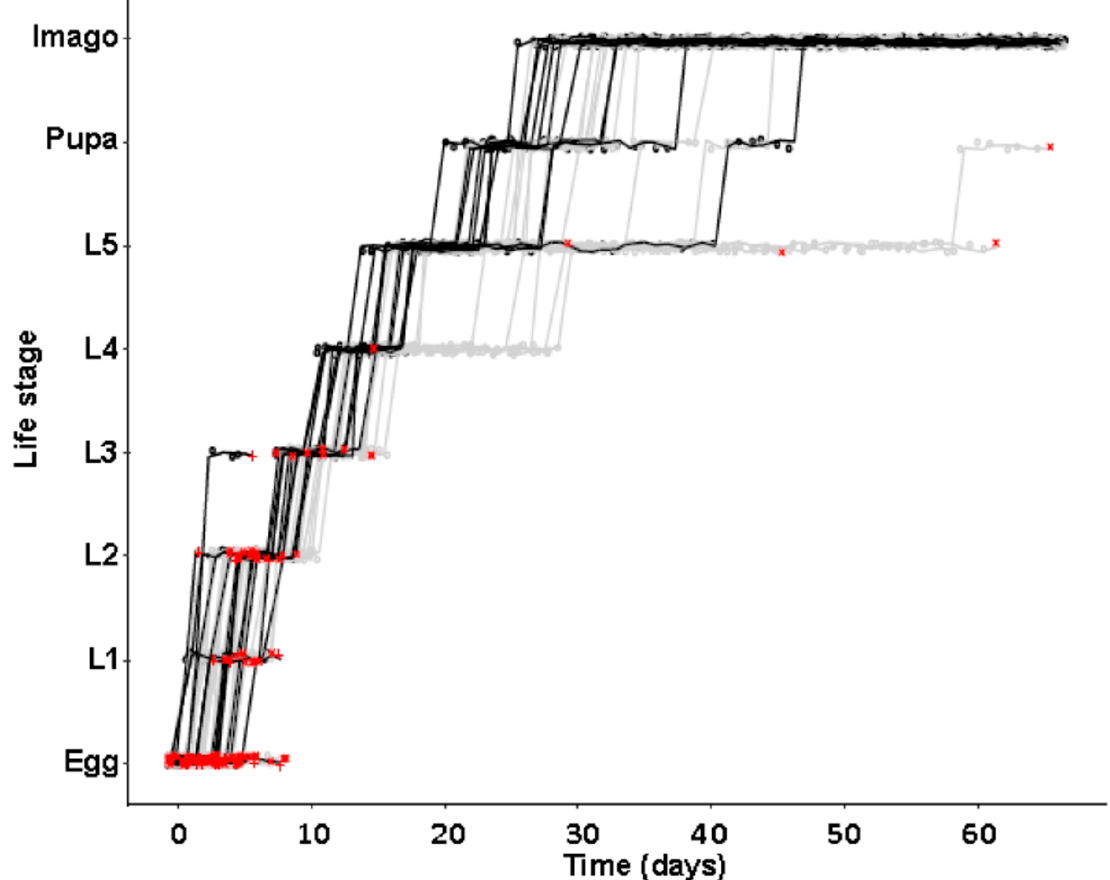
Figure 2. Cumulative developmental time until the end of different life stages of aposymbiotic (grey dots and lines) versus symbiotic (black dots and lines) O. surinamensis beetles from the JKI-1 lines. Red ‘ + ’ and ‘ × ’ signs indicate death of symbiotic and aposymbiotic individuals, respectively. Significant differences were observed for transitioning from larval instars 3 to 4 and instar 4 to 5 after Wilcoxon rank sum test corrected for FDR following Benjamini–Hochberg (* = p < 0.05, all other comparisons p > 0.05).